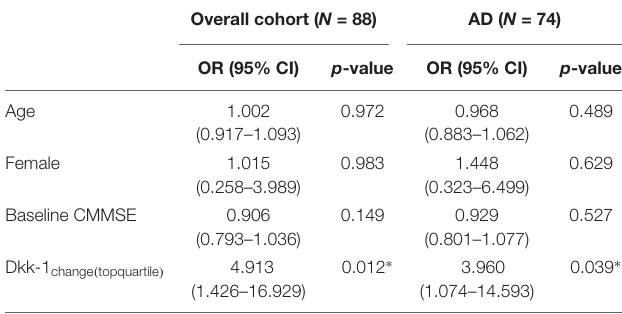
TABLE 4 | Multiple logistic regression for global cognitive